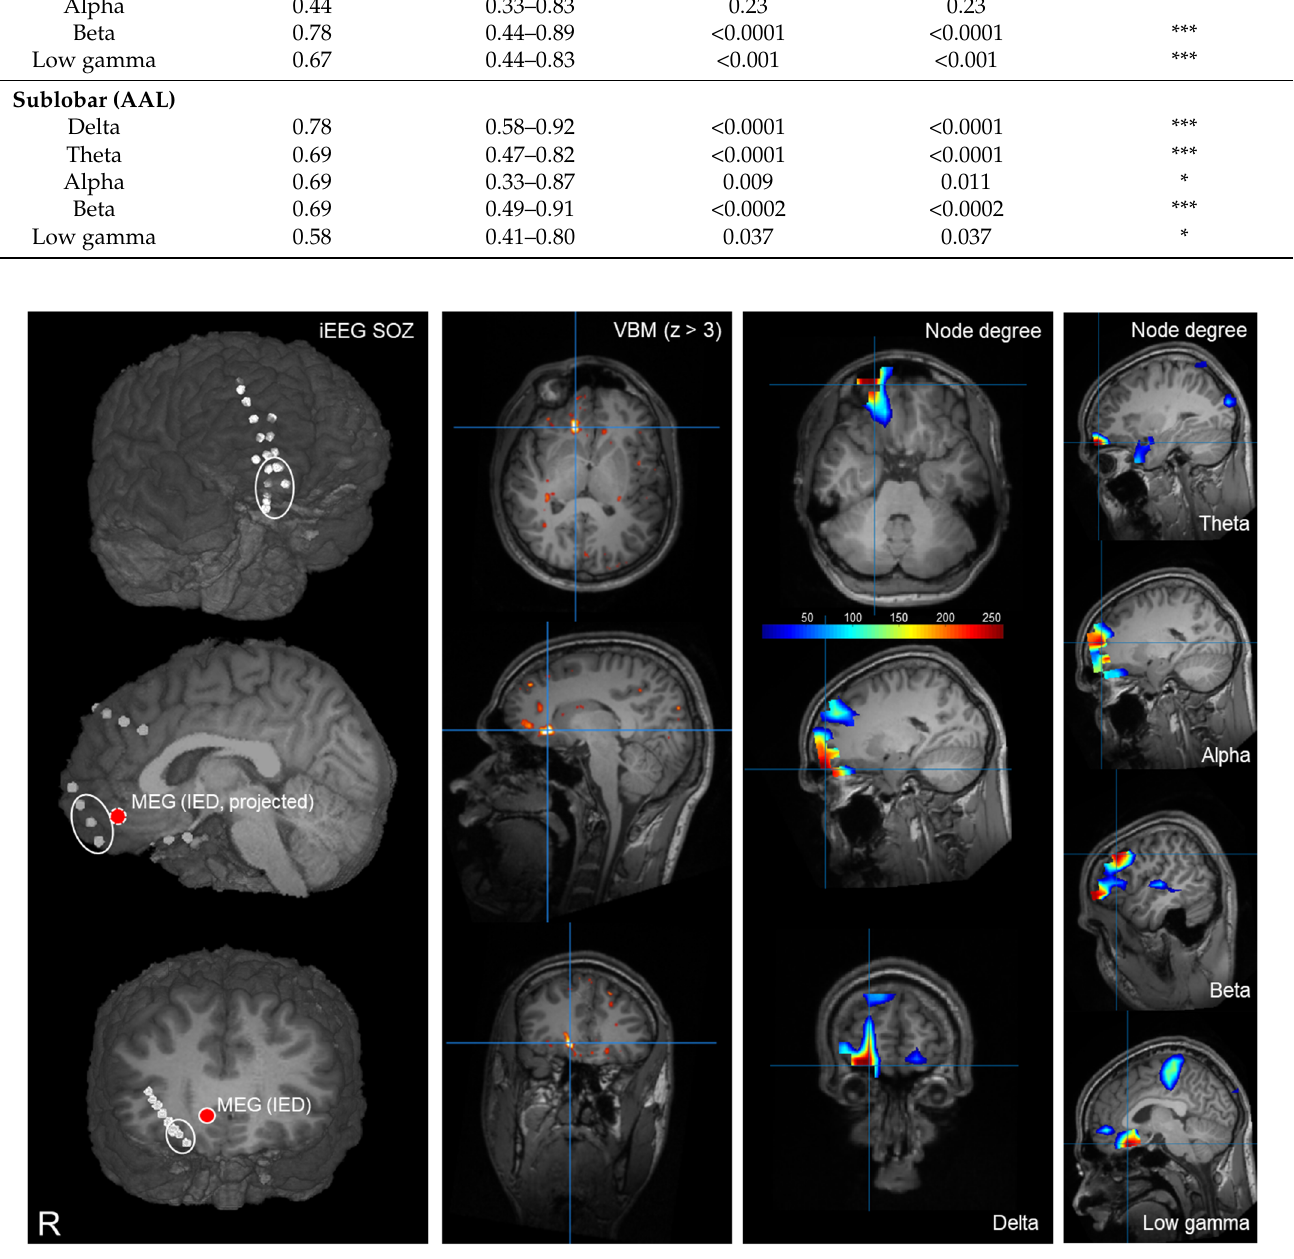
Figure 1. Example case of a patient with right fronto-polar focal cortical dysplasia type IIb. The first column shows the iEEG findings; fronto-polar SOZ electrodes are circled. Lower inset shows depth electrodes inserted into the lesion. The circle marker shows the localization from routine MEG analysis based on IEDs. Second column shows MRI postprocessing (voxel-based morphometry, MAP19, combined z-score, thresholded at z > 3) superimposed on the patient’s T1. Third column shows delta band node degree (thresholded at 95th percentile to illustrate maximum, see Supplementary Figure S1 for full distributions). Right-most column shows sagittal slices of node degree in the other frequency bands (thresholded). The patient underwent epilepsy surgery and was seizure-free thereafter for several years; however, the patient then developed recurrent seizures with a reduced frequency.